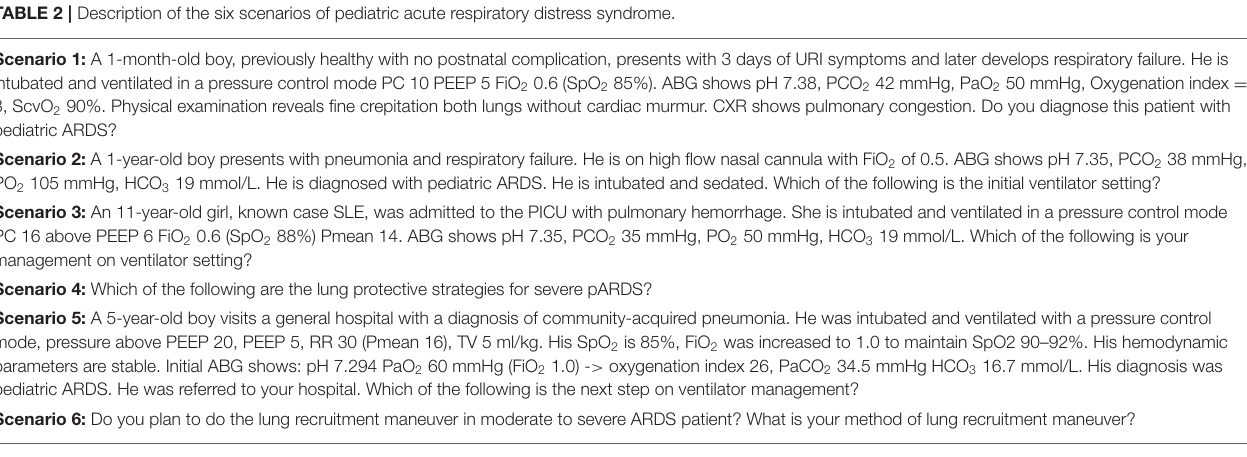
TABLE 2 | Description of the six scenarios of pediatric acute respiratory distress